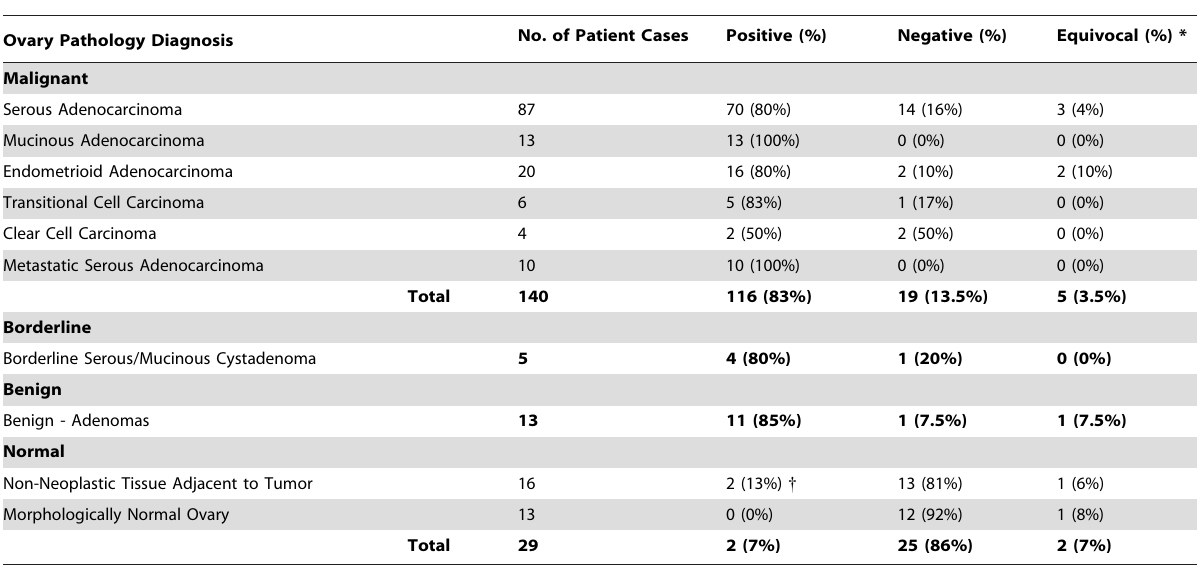
Table 2. S100A6 immunohistochemical findings in epithelial OVCA and ovary tissues.